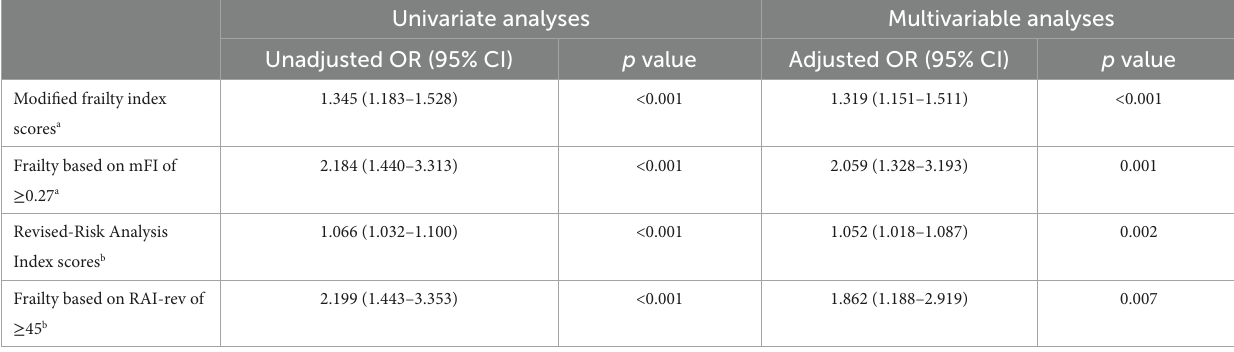
Supplementary Table S6 for details. b After testing for multicollinearity, RAI-rev (as continuous or dichotomous variable) and other factors with p values <0.10 in univariate logistic regression analyses (including body mass index, hypertension, coronary heart disease, previous stroke, diabetes mellitus, hypoalbuminemia, hyponatremia, and risk stratification and duration of surgery) were included in the multivariable logistic regression model to identify the adjusted association between high RAI-rev (per 1-point increase in RAI-rev score or RAI-rev of ≥ 45) and the primary outcome. The 11 variables covered by the RAI-rev were not separately enrolled in multivariable analyses. See Supplementary Table S7 for